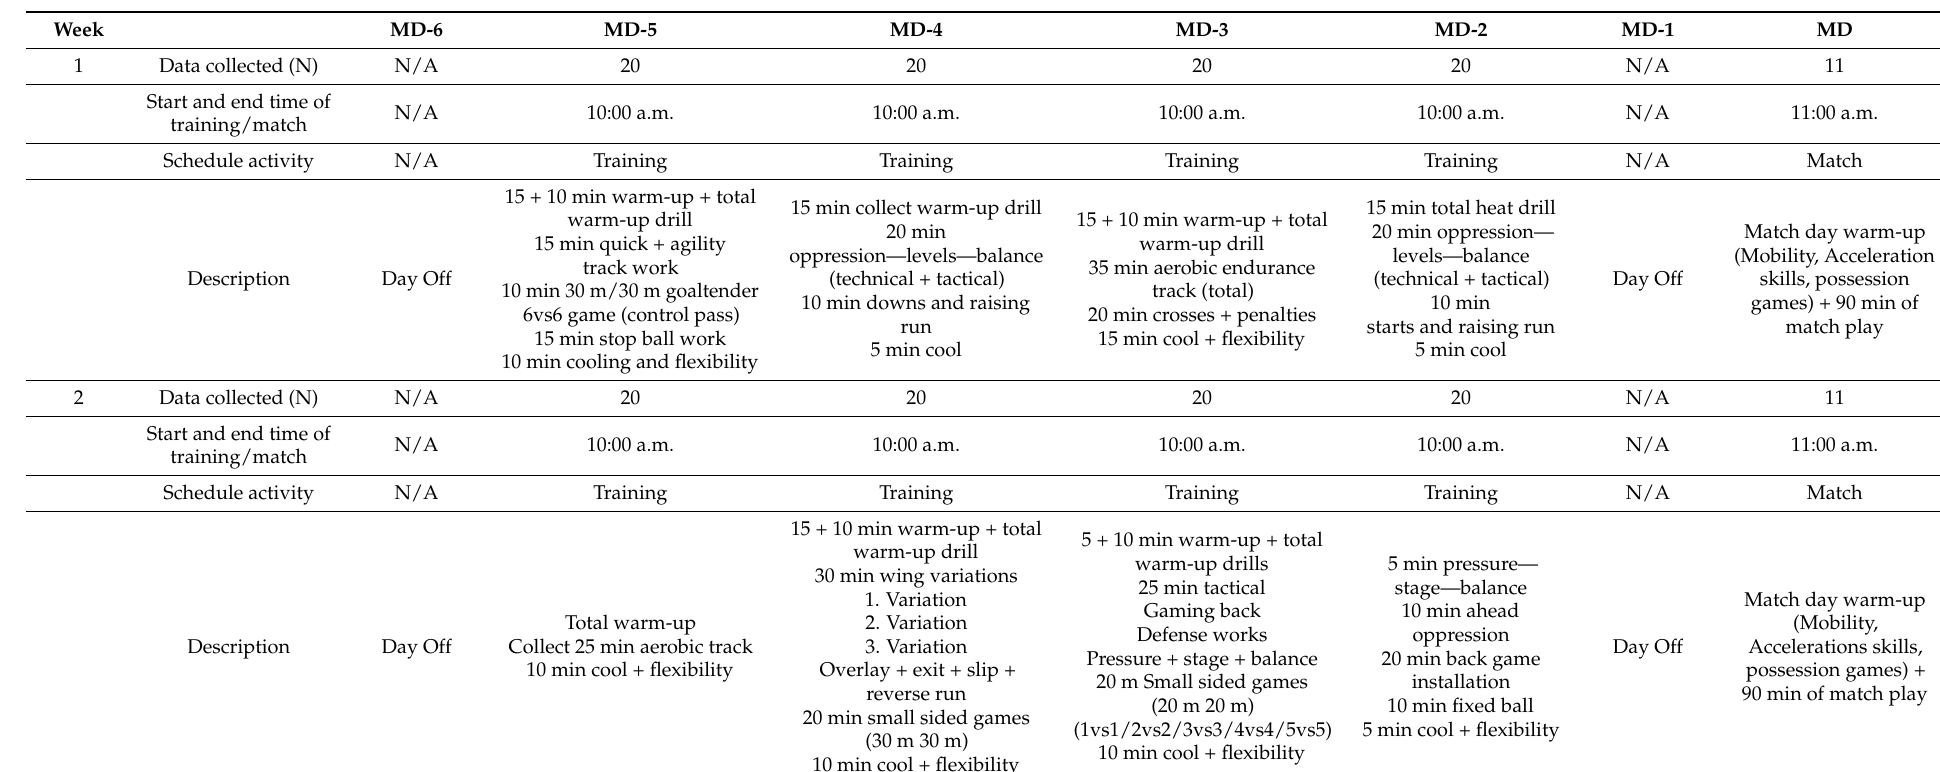
Table 2. Overview of the schedule activities (e.g., training, competition, recovery) during the observed training